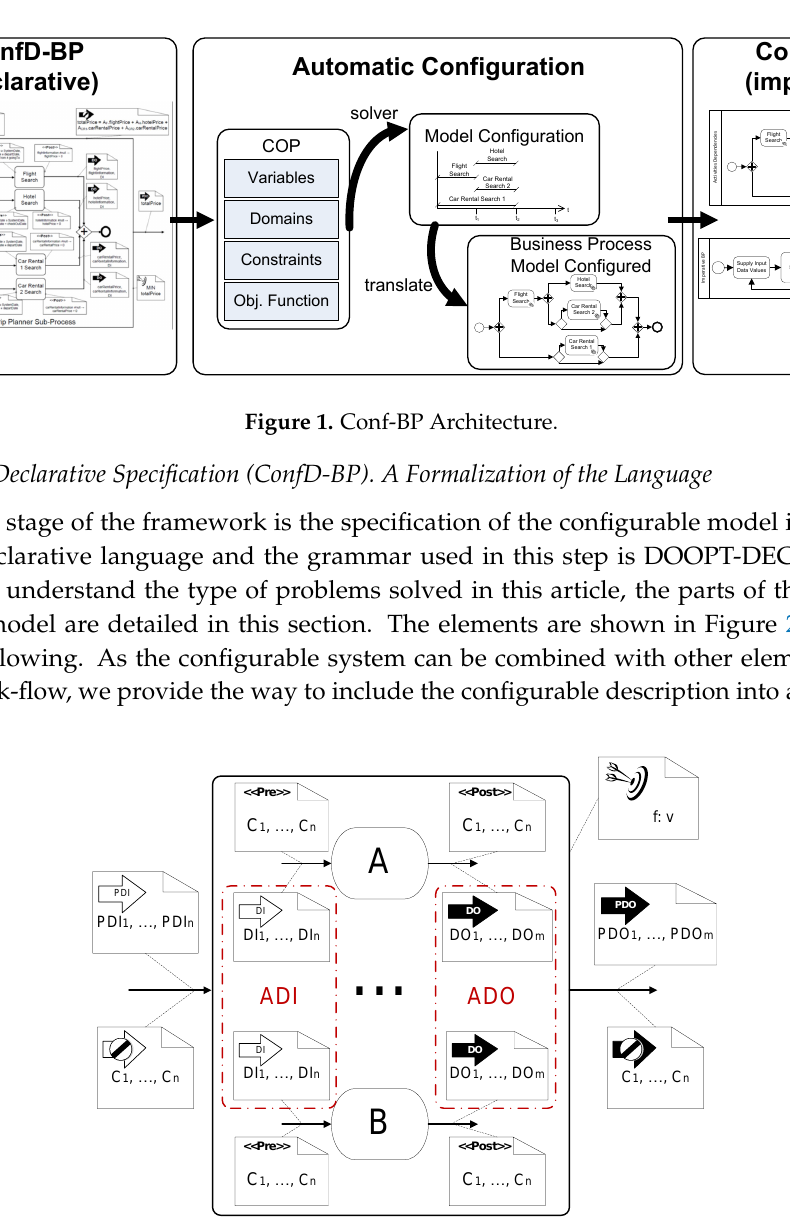
Figure 2. Parts of the Configurable Declarative Description